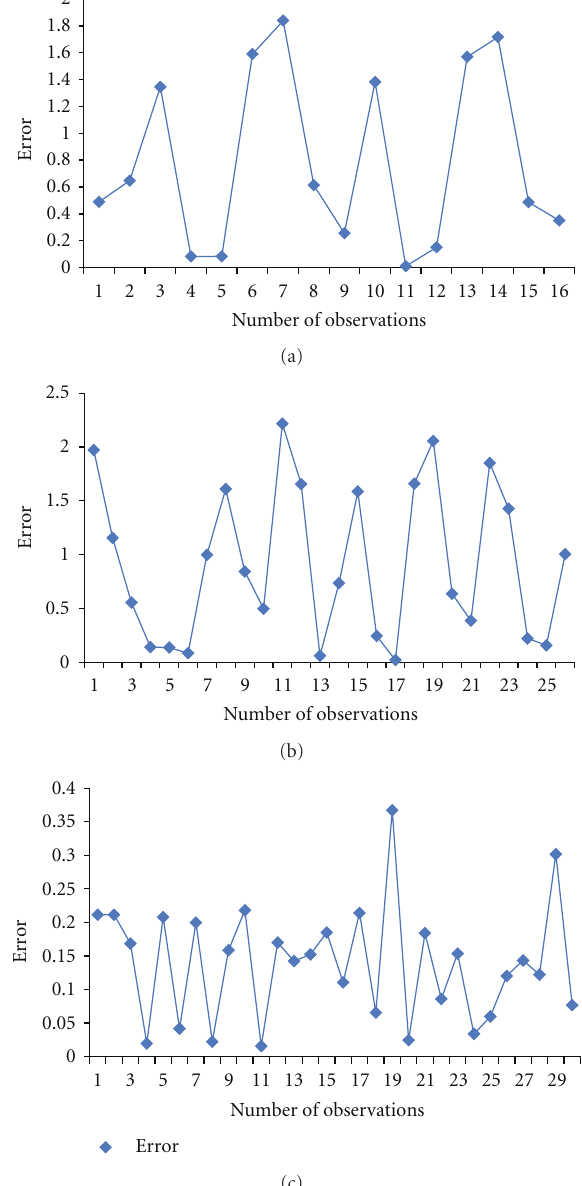
Figure 5: (a, b, and c) Error graphs for all three datasets (1, 2, 3).